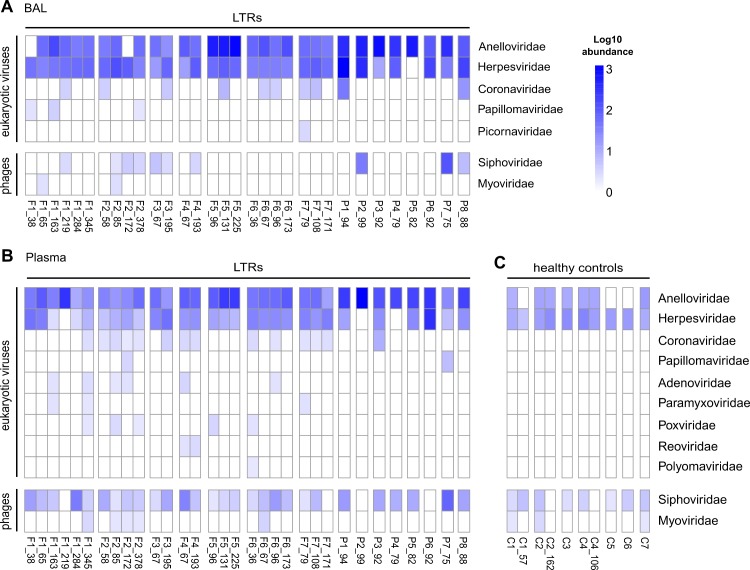
Viral families identified in 15 lung transplant recipients.(A) Viral families identified in BAL samples, and (B) plasma samples obtained simultaneously at different time points after transplantation (F1-F7: LTRs with follow up samples; P1-P8: LTRs tested at only one time point). (C) Viral families identified in 7 healthy controls (C1-C7). Numbers after the patient identifier indicate days after transplantation for LTRs; and days between first and second sample for the healthy controls. Log10 abundance in reads per million.